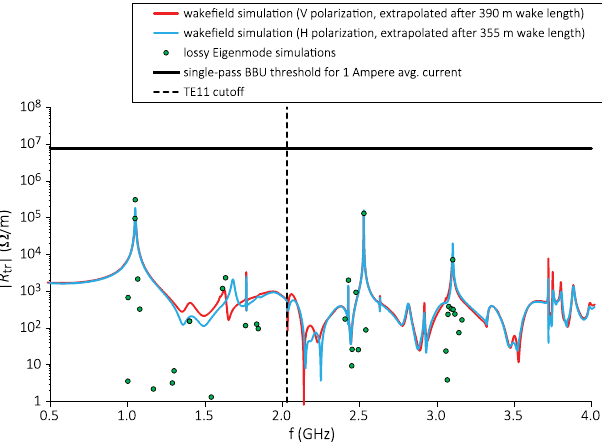
FIG. 7. Cavity dipole impedance spectra (solid lines denote wakefield calculations with beam traversing off axis with a radial offset r either in horizontal or vertical direction; green dots denote complex Eigenmode computations, either polarization). The horizontal black line is the single-pass BBU impedance threshold impedance for a 1 A average beam